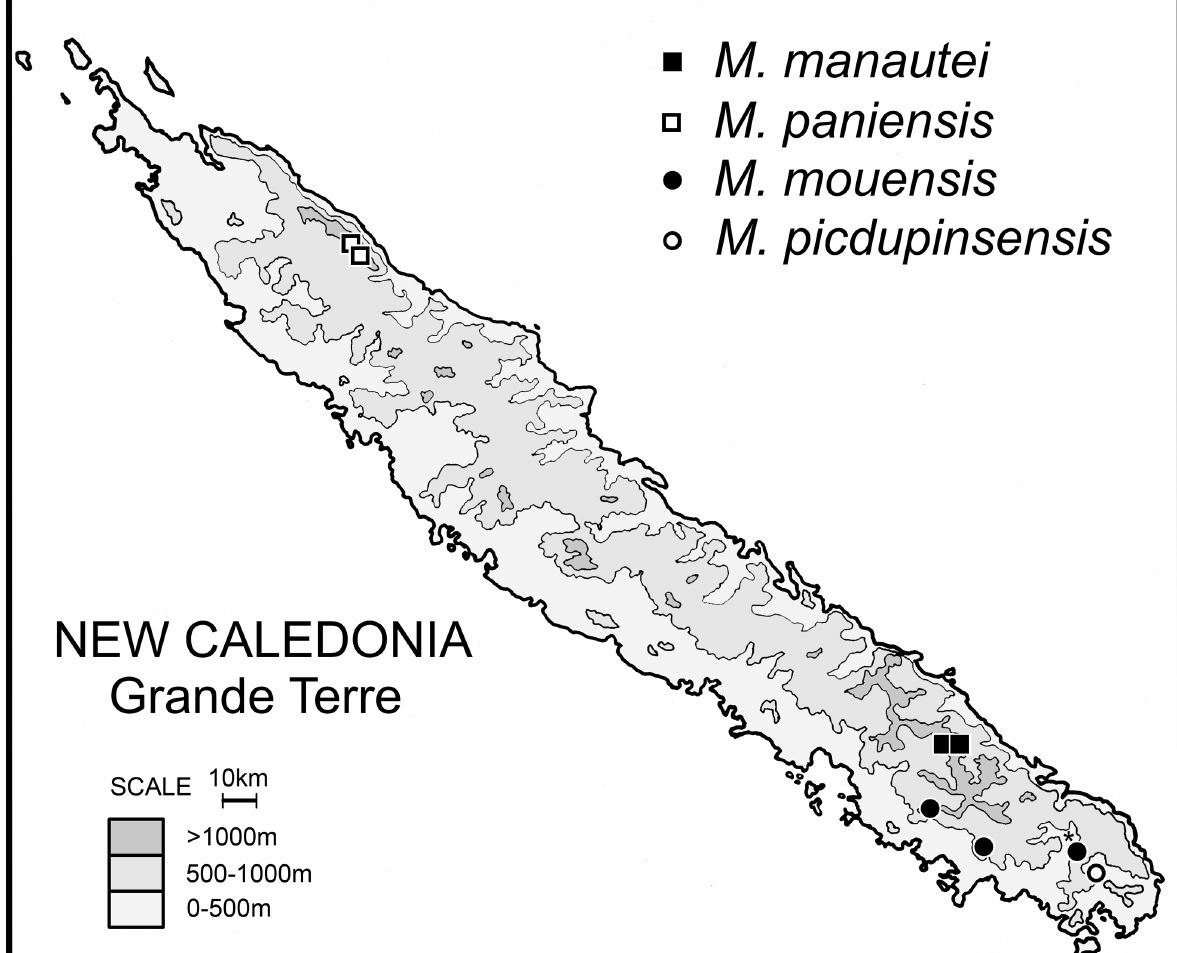
Figure 25. Geographical distributions of Mecyclothorax ( Phacothorax ) spp. (asterisked locality attributed to M. mouensis based on non-type female